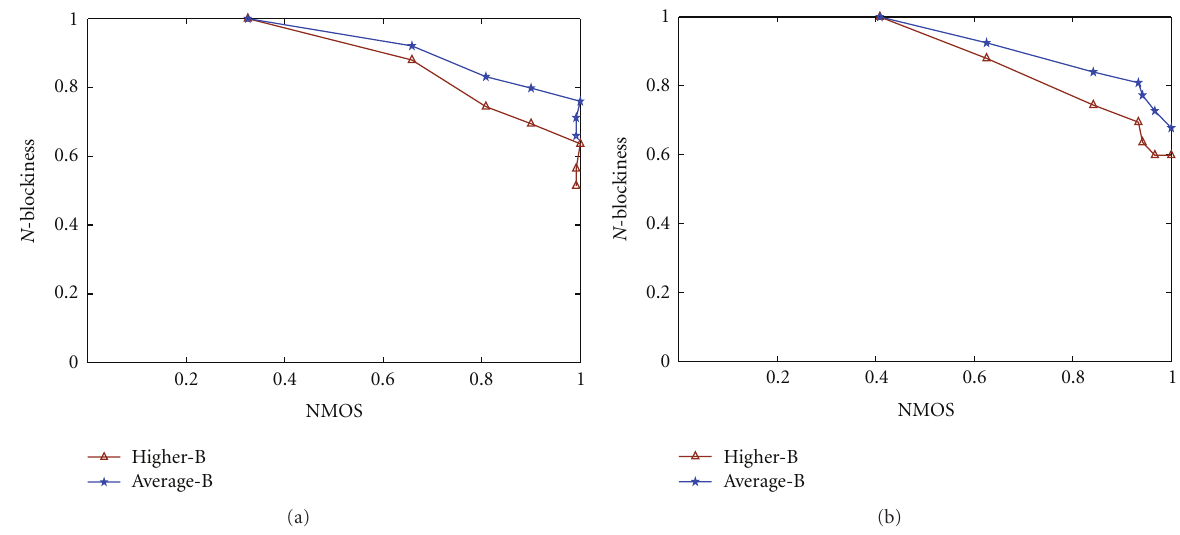
Figure 4: Normalized MOS versus blockiness for di ff erent Cattle image pairs. (a) L, R: Ref-QS10, Ref-QS15, Ref-QS27, Ref-QS37, Ref-QS55, Ref-QS79, and Ref-Ref, (b) L, R: QS79-QS10, QS79-QS15, QS79-QS27, QS79-QS37, QS79- QS55, QS79-QS79, and QS79-Ref.